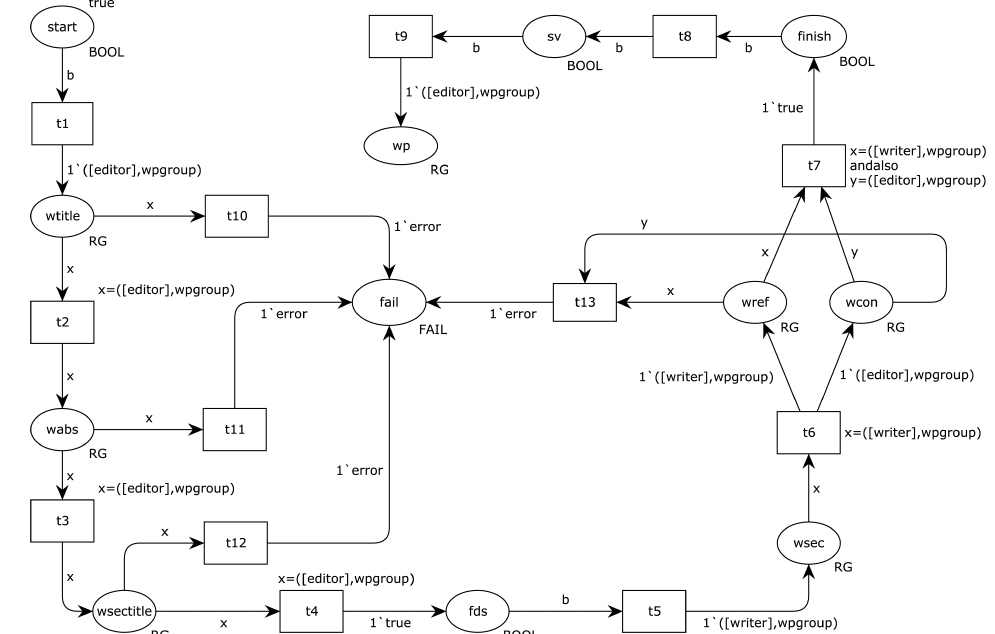
Figure 15. The CPN4M to Writing Paper : failures